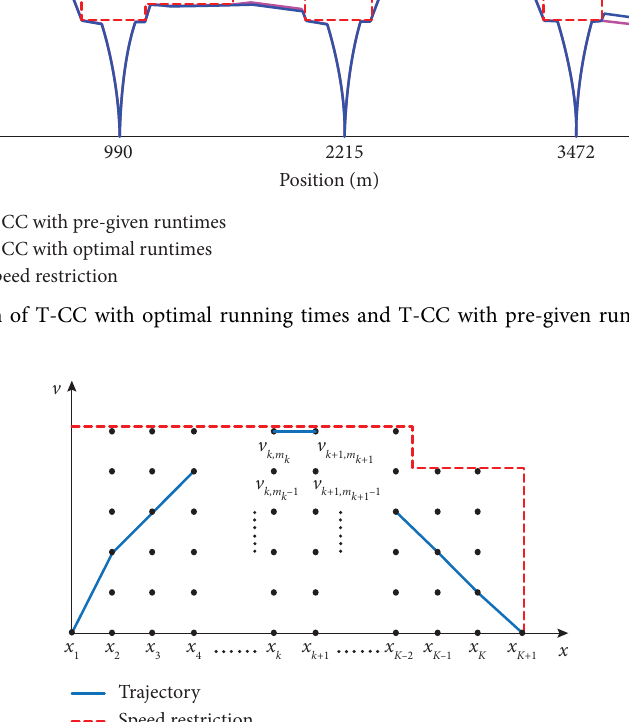
Figure 12: Te illustration of the speed-distance network.